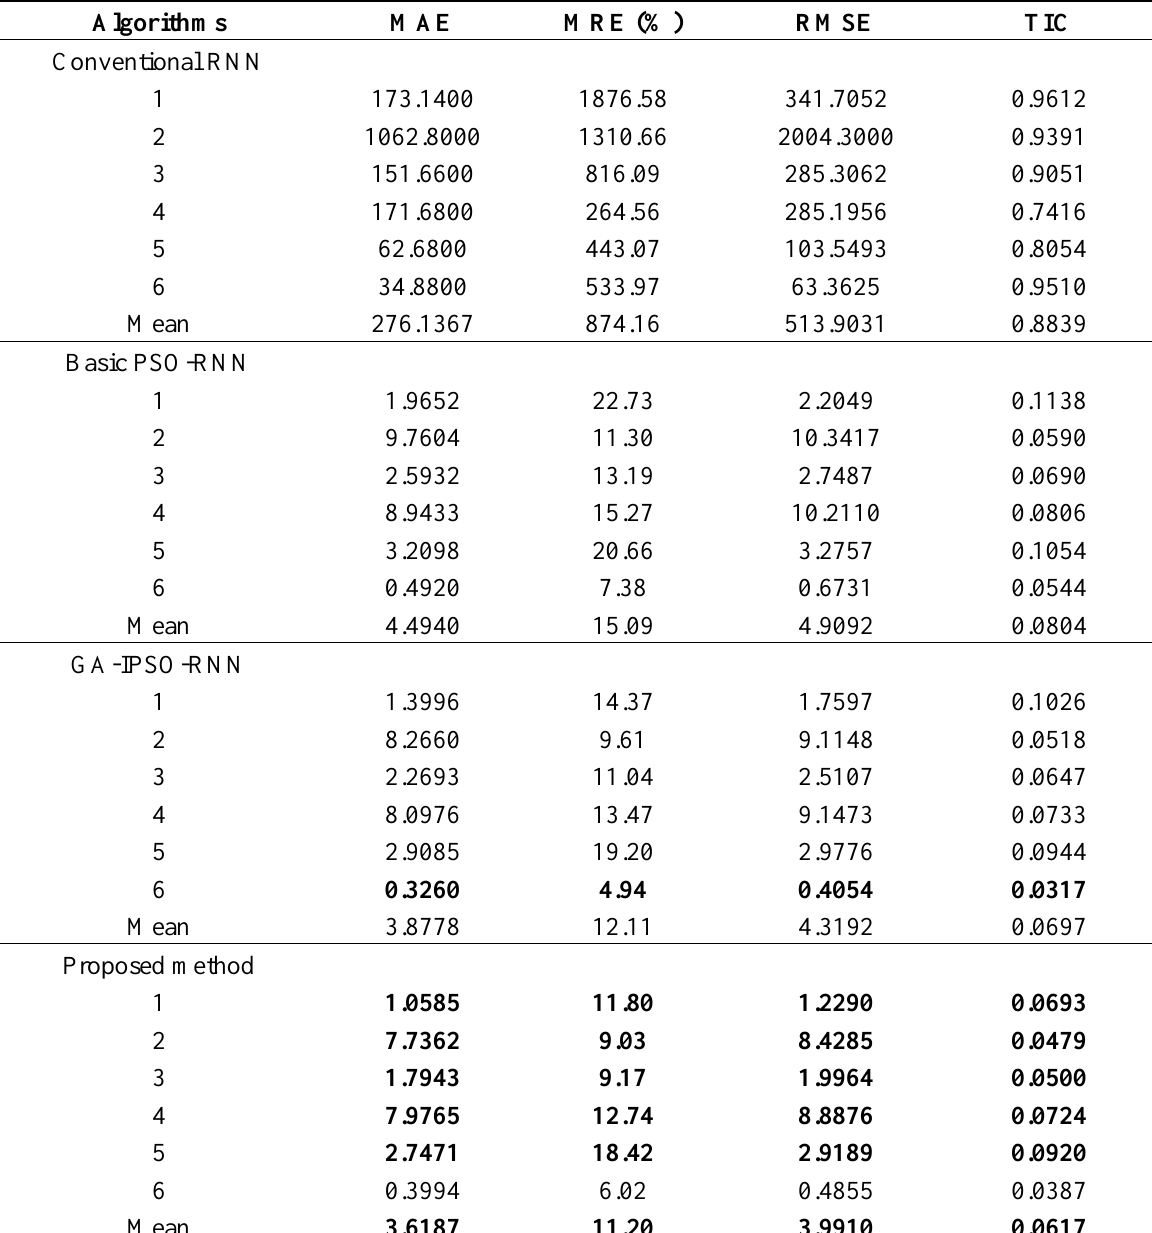
Table 3. Comparison of errors among the proposed methods, the GA-IPSO-RNN [9], the basic PSO-RNN [9], and the conventional RNN